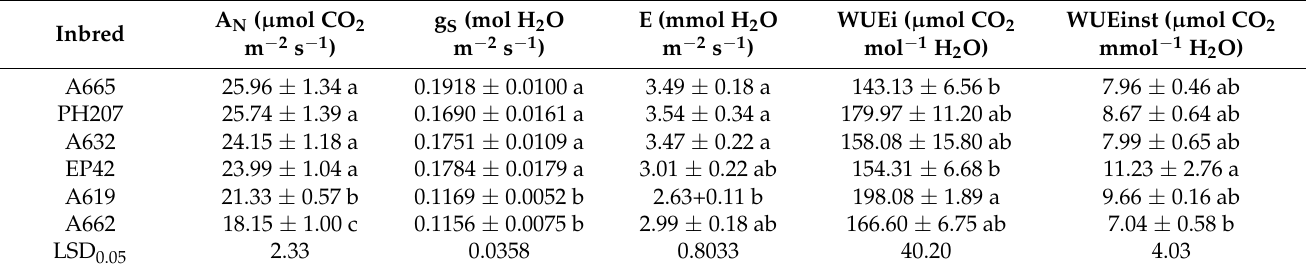
Figure 1. Histogram of best linear unbiased estimators for photosynthesis-related traits in a large maize association panel across three years. A N : Leaf net photosynthesis; g S : Stomatal conductance; E: Transpiration rate; WUEi: Intrinsic Water use efficiency; WUEinst: Instantaneous Water use efficiency. Table 1. Comparison of means ( ± standard deviations) of the six maize inbred lines used as checks for photosynthetic traits.